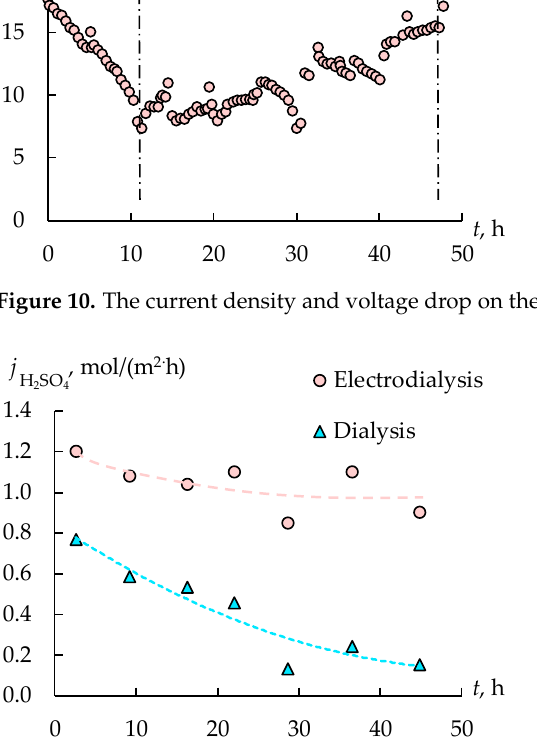
Figure 11. The fluxes of sulfuric acid during dialysis and electrodialysis.